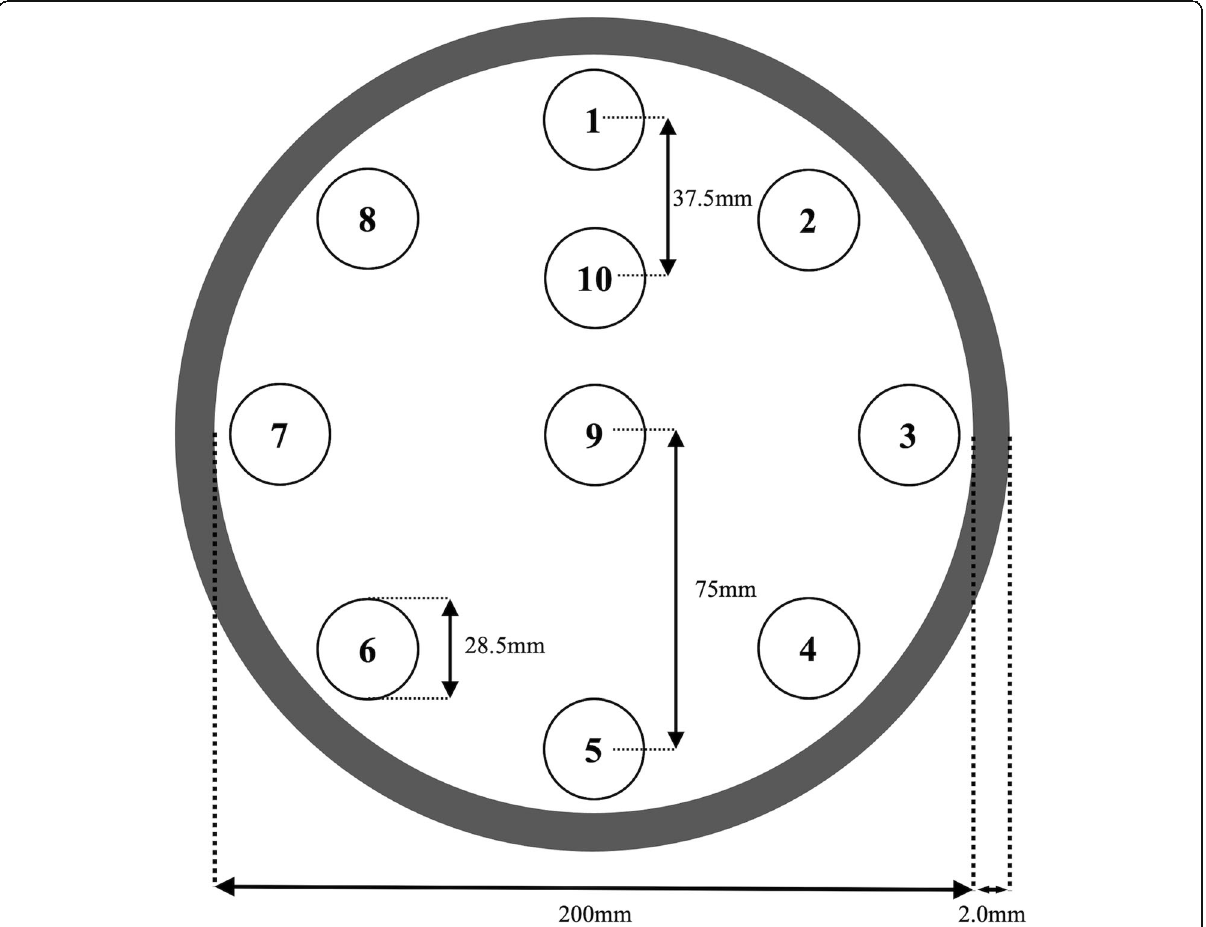
Fig. 1 Schematic of multi-energy computed tomography (CT) phantom. The CT scans were performed with and without the x-ray attenuation rubber layer (width 2.0 mm, indicated as a gray